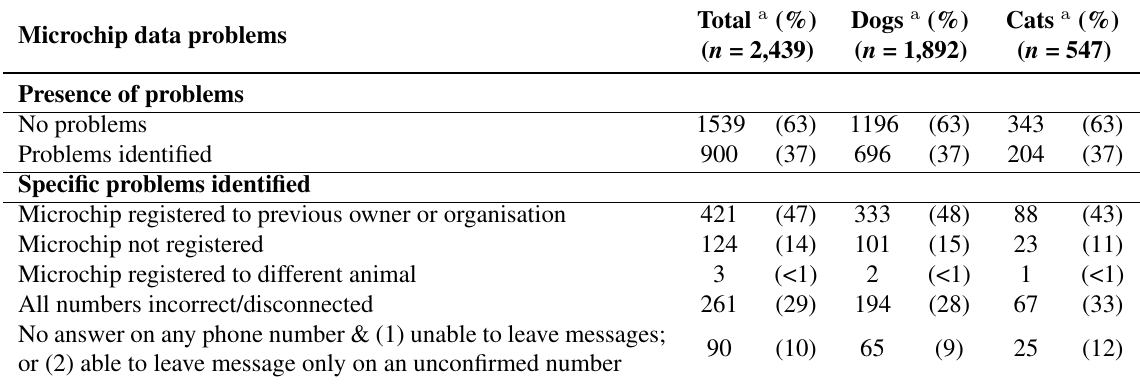
Table 4. Frequency of each problem identified with the microchip data of 2439 microchipped stray adult dogs and cats entering RSPCA-QLD shelters (January 2012–December 2013). Percentages of the problems identified in each category are shown in brackets.